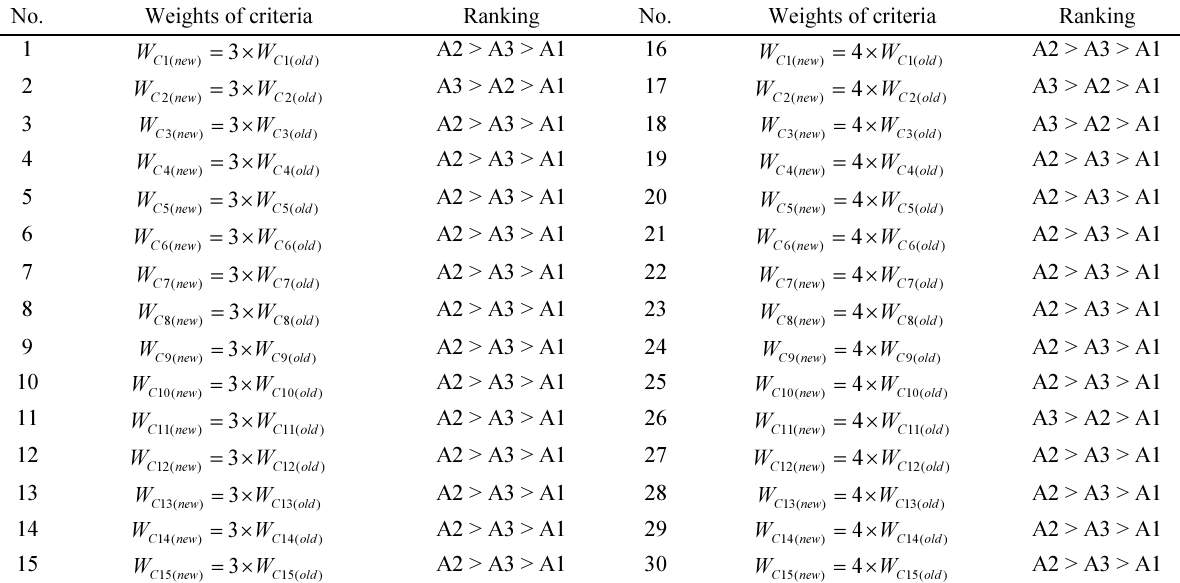
Table 10. Changing the criteria weights for sensitivity analysis No. Weights of criteria Ranking No. Weights of criteria